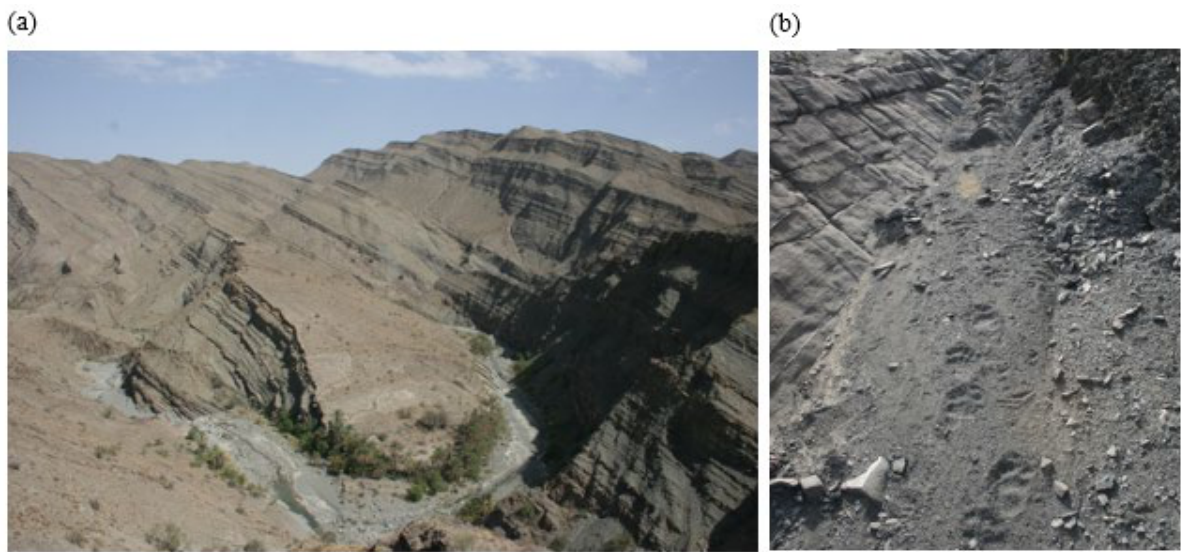
Figure 6. Asiatic black bears in an arid environment at the western edge of their geographic range in southeastern Iran rely on date palm ( Phoenix dactylifera ) and other abandoned orchards as primary food sources. ( a ) They use valleys with water sources as places to obtain foods and as travel corridors. ( b ) Footprints of a bear in a valley bottom. Photos: A. Ghoddousi; T. Ghadirian.